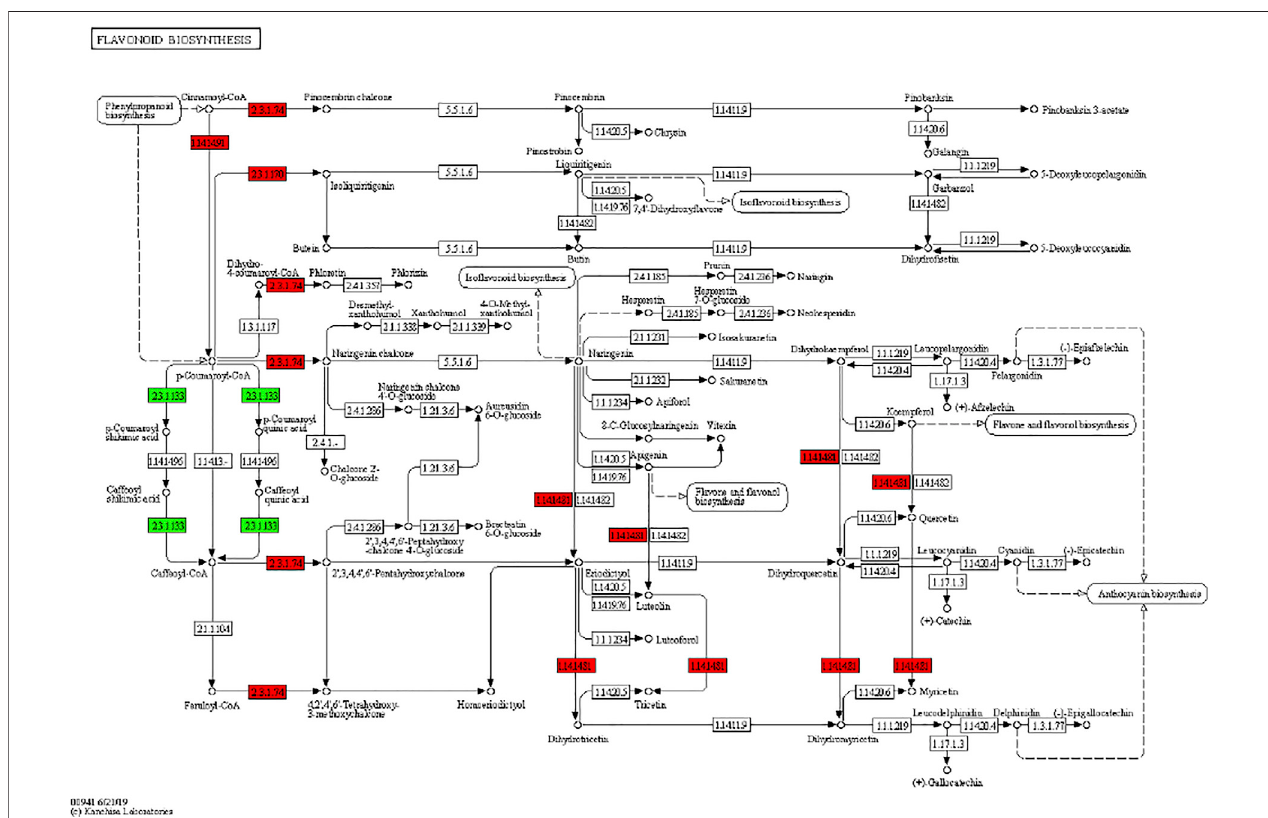
FIGURE 5 | Differential regulation of fl avonoid biosynthesis pathway in banana peels treated with or without UV-C irradiation. Number in the boxes represent E.C. numbers of the enzymes. Red and green color indicates upregulation and downregulation of genes in response to UV-C treatment.